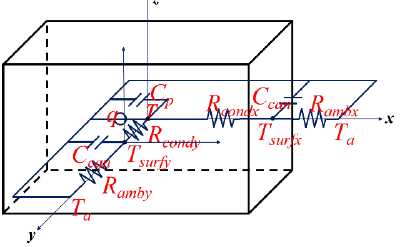
Figure 1. Structure diagram of the two-dimensional thermal resistance model [29].